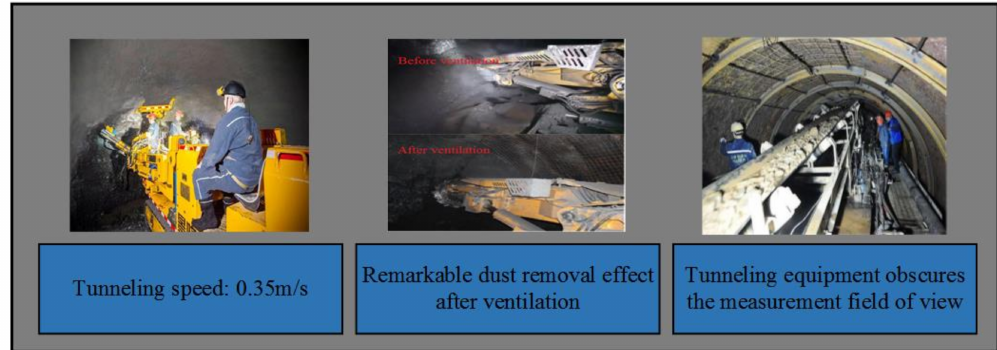
Figure 5. External features of a tunneling